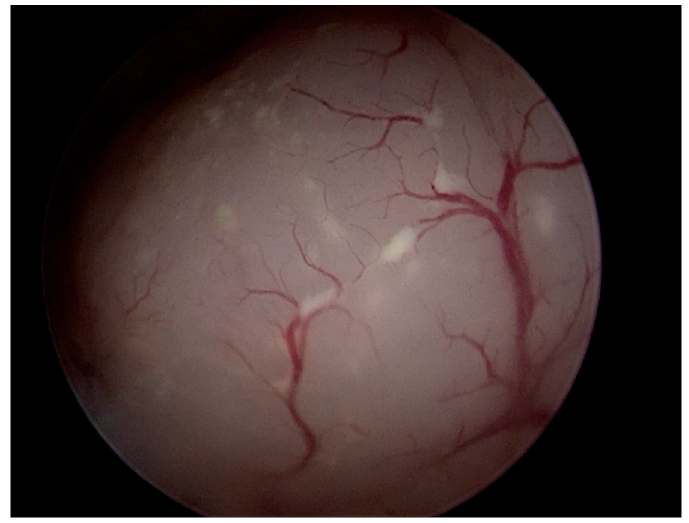
Figure 4. Atypical vascularization at hysteroscopic